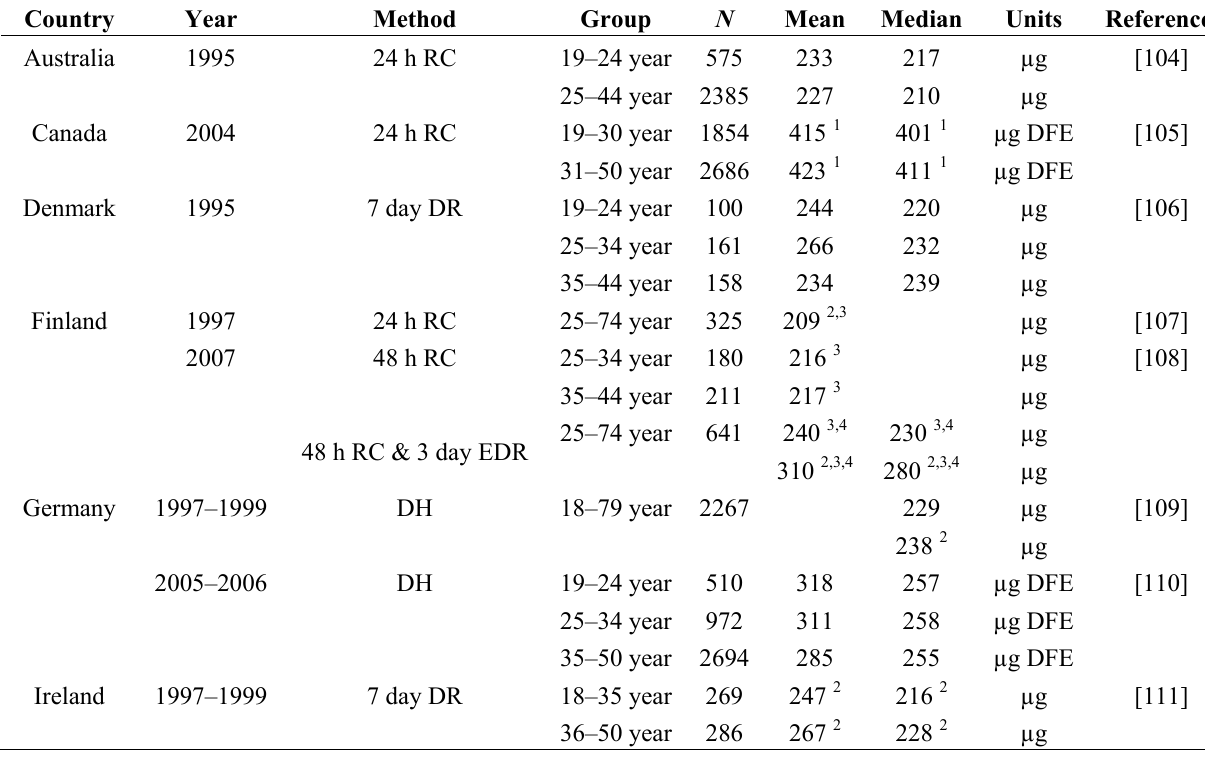
Table 3. Mean and median intakes of folate for women from population survey data by country.